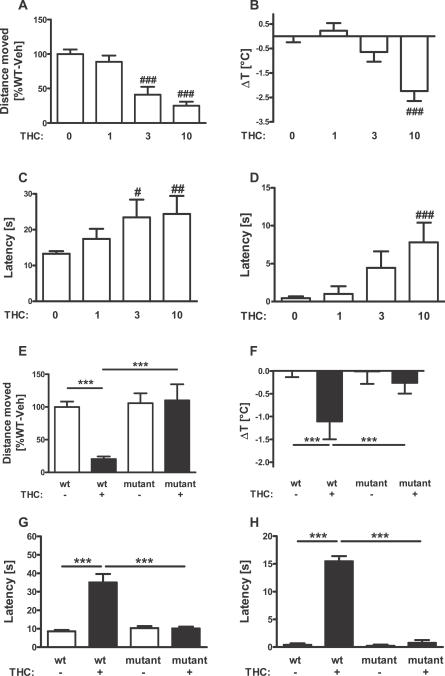
Hypolocomotor, Hypothermic, Analgesic, and Cataleptic Effects of THC Depend on CB1 Receptors(A–D) Dose-response of THC effects in wild-type mice. Effects of vehicle (n = 16), 1 mg/kg (n = 9), 3 mg/kg (n = 9), and 10 mg/kg THC (n = 10), respectively, on the “tetrad” battery of tests consisting of (A) locomotor, (B) hypothermic, (C) analgesic, and (D) cataleptic effects. (E–H) THC effects depend on CB1 receptor. Wild-type CB1
+/+ and littermate CB1
−/− mice (i.e., null CB1 mutants) were tested for (E) locomotor, (F) hypothermic, (C) analgesic, and (D) cataleptic effects of 10 mg/kg THC. Note the absence of any effect of the drug in CB1
−/−. #, ##, ###; p < 0.05, p < 0.01, p < 0.001, respectively, as compared to vehicle-treated animals (two-way ANOVA, followed by Dunnet's post-hoc test). ***, p < 0.001 (two-way ANOVA, followed by Newman-Keuls post-hoc test).